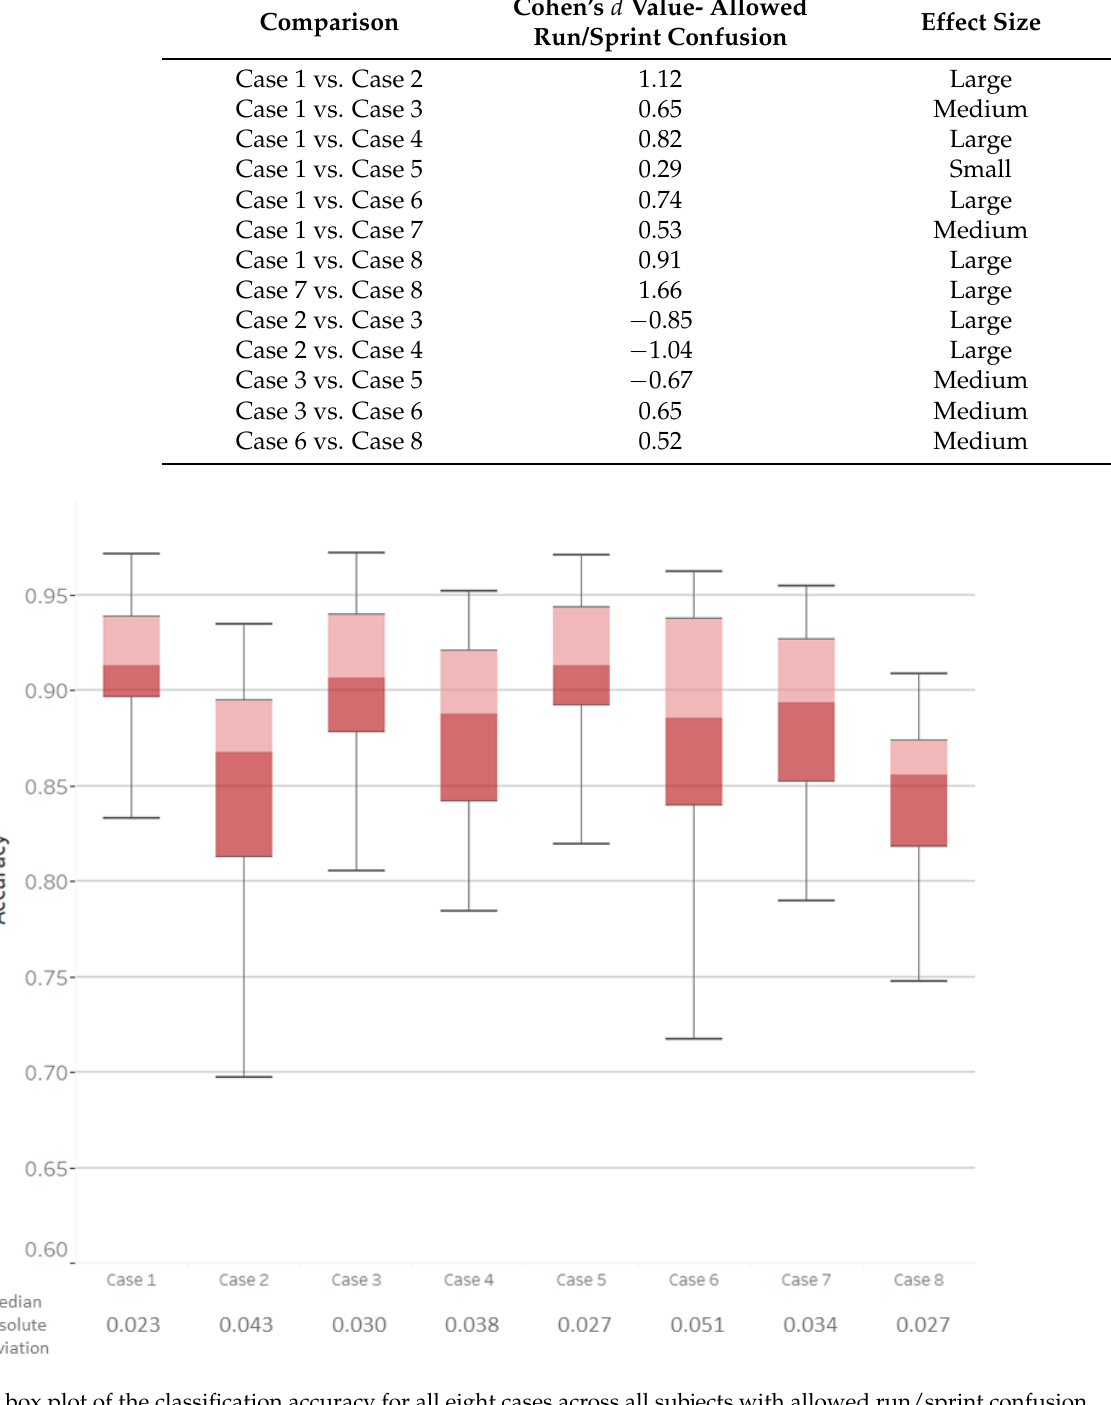
Table 3. Cohen’s d effect sizes.